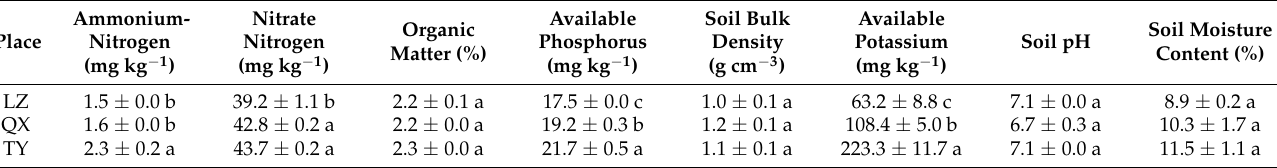
Table 1. Basic physical and chemical properties in the rhizosphere soil in three orchards. Ammonium- Place